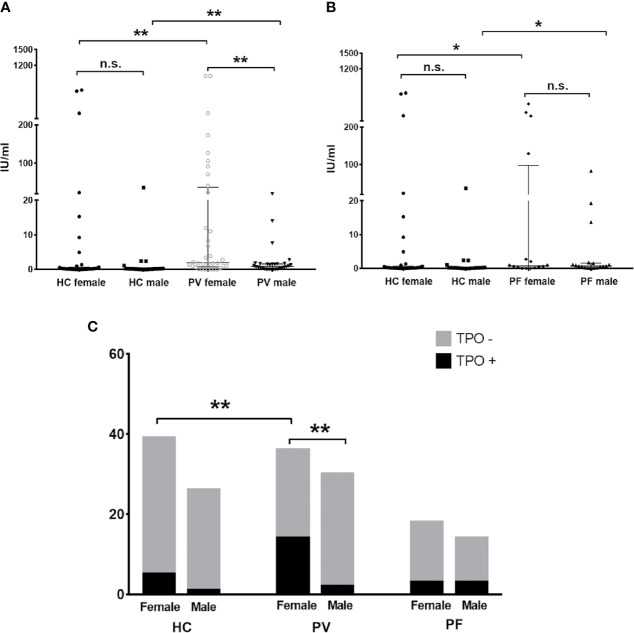
The status of anti-TPO antibody in PV patients, PF patients and healthy controls. (A, B) The levels of anti-TPO antibody in PV patients, PF patients and healthy controls, shown as median with interquartile range. (C) The antibody positivity of anti-TPO antibody in PV patients, PF patients and healthy controls. * indicates a significant difference (*p < 0.05, **p < 0.01, ***p < 0.001, by the Mann-Whitney U test for the comparison of antibody levels and The Fisher’s exact test for the comparison of antibody positivity).